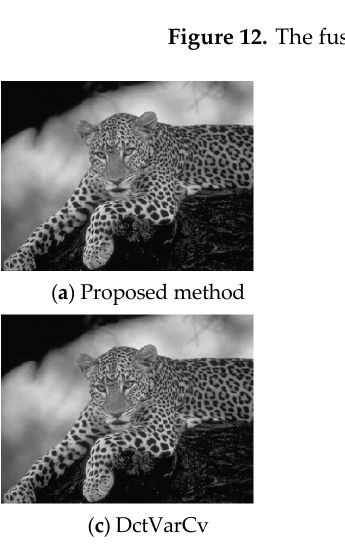
Figure 13. The fusion result of the leopard image.